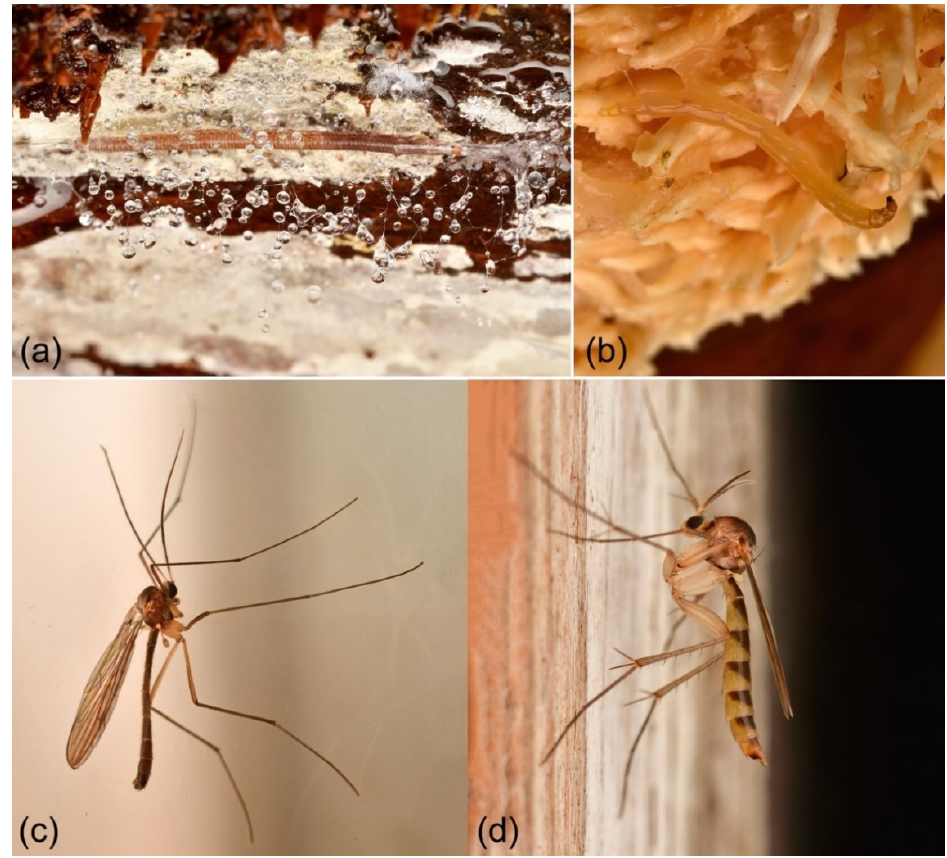
Figure 1. Examples of Sciaroidea flies. ( a ) Larva of cf. Rocetelion humerale (Zetterstedt, 1850), family Keroplatidae, spinning net under a huge decaying log of beech; ( b ) larva of Sciophila varia (Winnertz, 1864), family Mycetophilidae, spinning net under a sporophore of the mushroom Hydnum repandum ; ( c ) adult male of Bolitophila cinerea Meigen, 1818, family Bolitophilidae; ( d ) adult female of Allodiopsis rustica (Edwards, 1941), family Mycetophilidae. All photos were taken by the author on October 2021 at Førde in Sveio municipality, Norway.